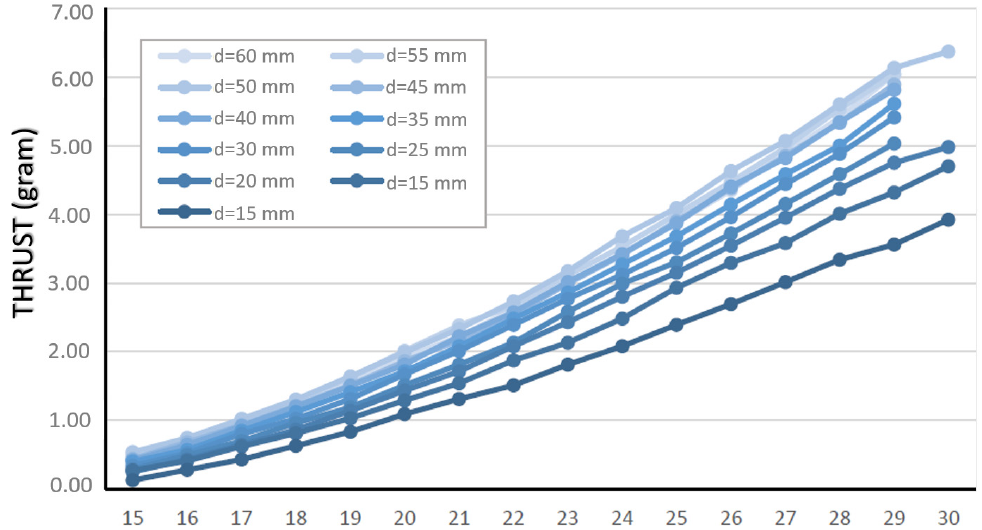
Figure 19. Dual thruster (400 mm electrodes): thrust vs. voltage for difference distances between cathode and anode.